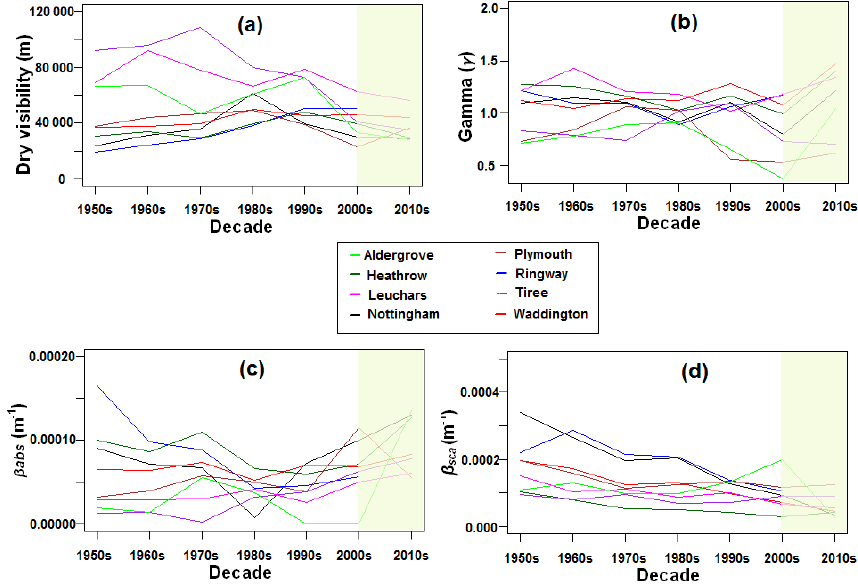
Figure 6. Model output parameters (a) dry visibility and (b) gamma, and (c) absorption coefficient and (d) scattering coefficient at 75% from the 1950s to 2010s. The green shaded region shows the start of the visiometer era at most of the stations (see Table S1 to see the starting year of visiometer